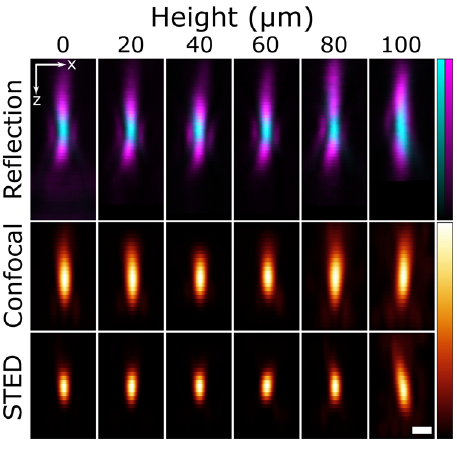
Fig. 4 Confocal and Z -STED point spread functions at different distances from the coverslip. The excitation (cyan) and depletion (magenta) lasers imaged in re fl ection using the sparse gold-core particles (top row). To correct for the mismatch between the immersion liquid of the objective and the sample, at every height the correction collar (CC) of the objective was adjusted to equalize the peak intensities of the axial STED lobes (see also Supplementary Fig. 4). Point spread functions in the XZ plane measured in confocal (middle row) and Z -STED (bottom row) mode using silica-coated fl uorescent beads dispersed in a disordered scaffold of unlabeled silica spheres (310 nm, 10% PDI, Supplementary Fig. 3). At least 10 well- separated beads were recorded and averaged at each height, and the PSFs were extracted by deconvolution with a sphere the size of the fl uorescent cores. The scale bar is 500